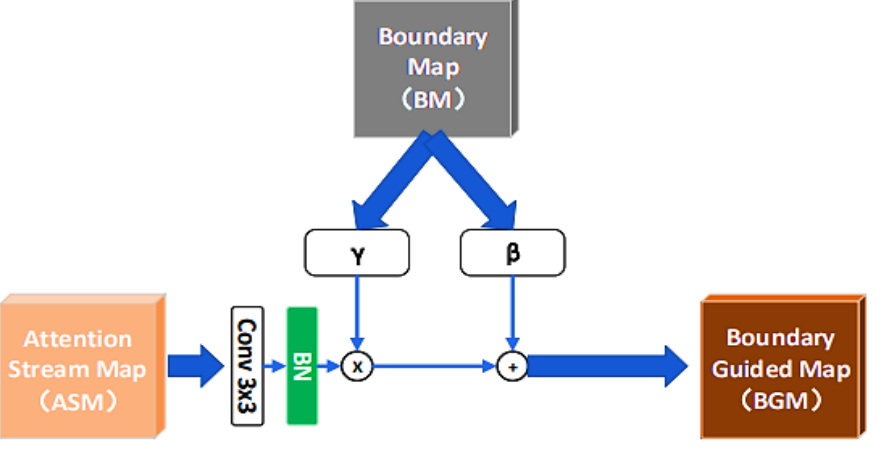
Figure 5. Boundary Guided Module [15].